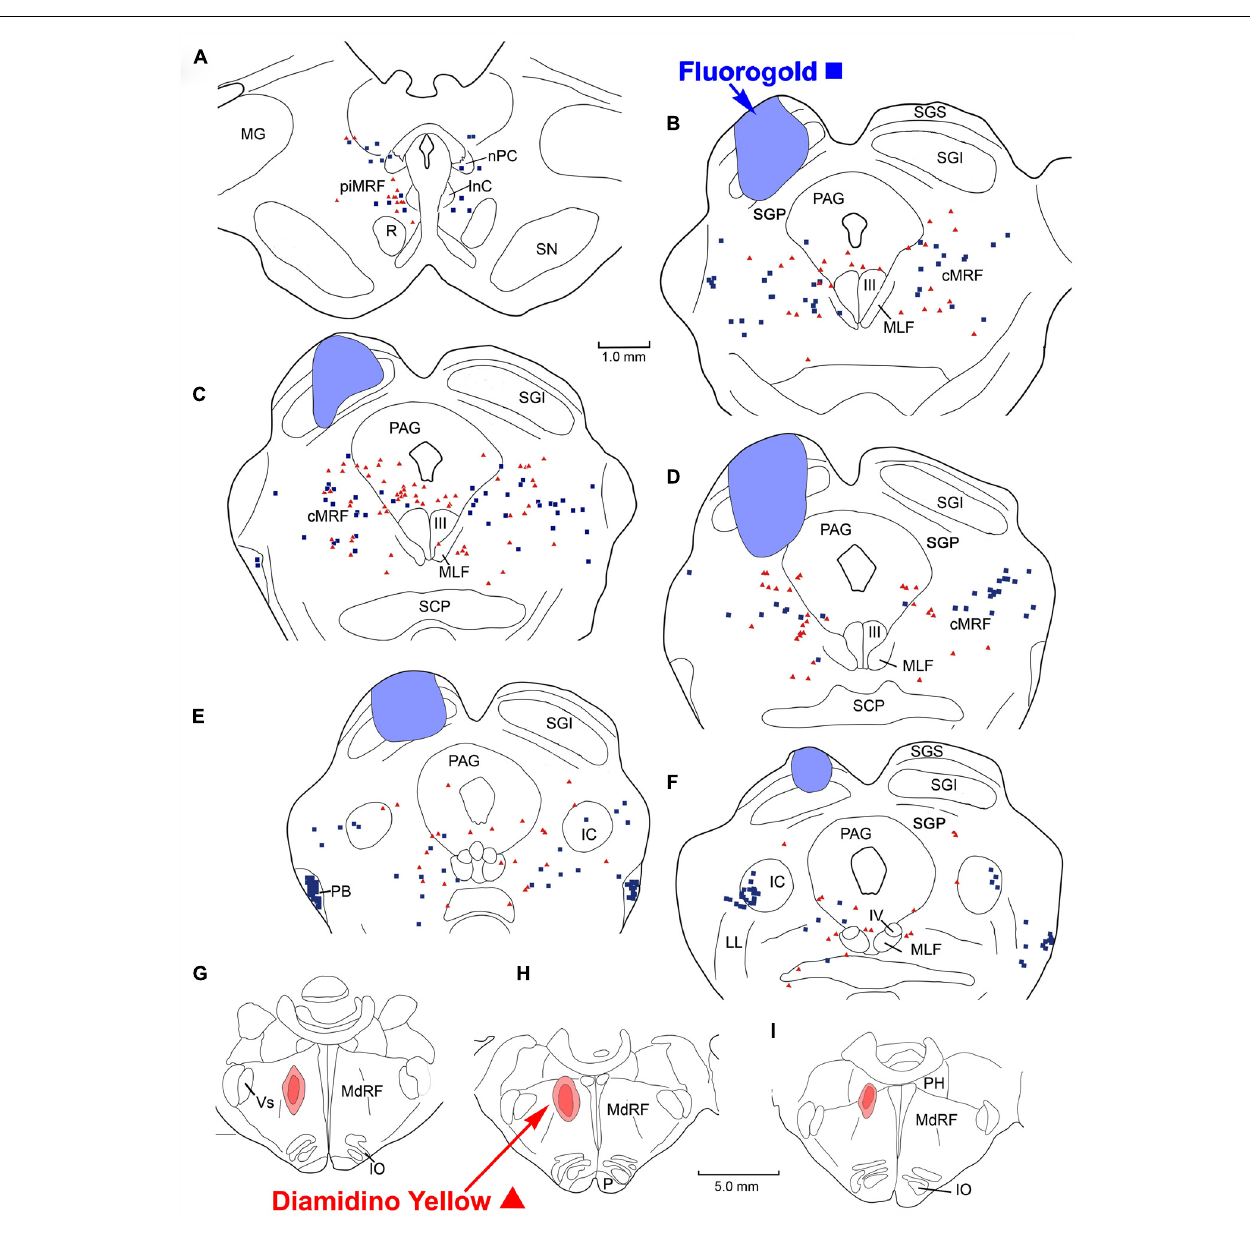
FIGURE 8 | Distribution of labeled reticulotectal neurons (cid:2) and medullary reticuloreticular neurons (cid:3) in MRF (A–F) produced by a FG injection in the SC (A–E) and a DY injection into the medial MdRF (G–I).